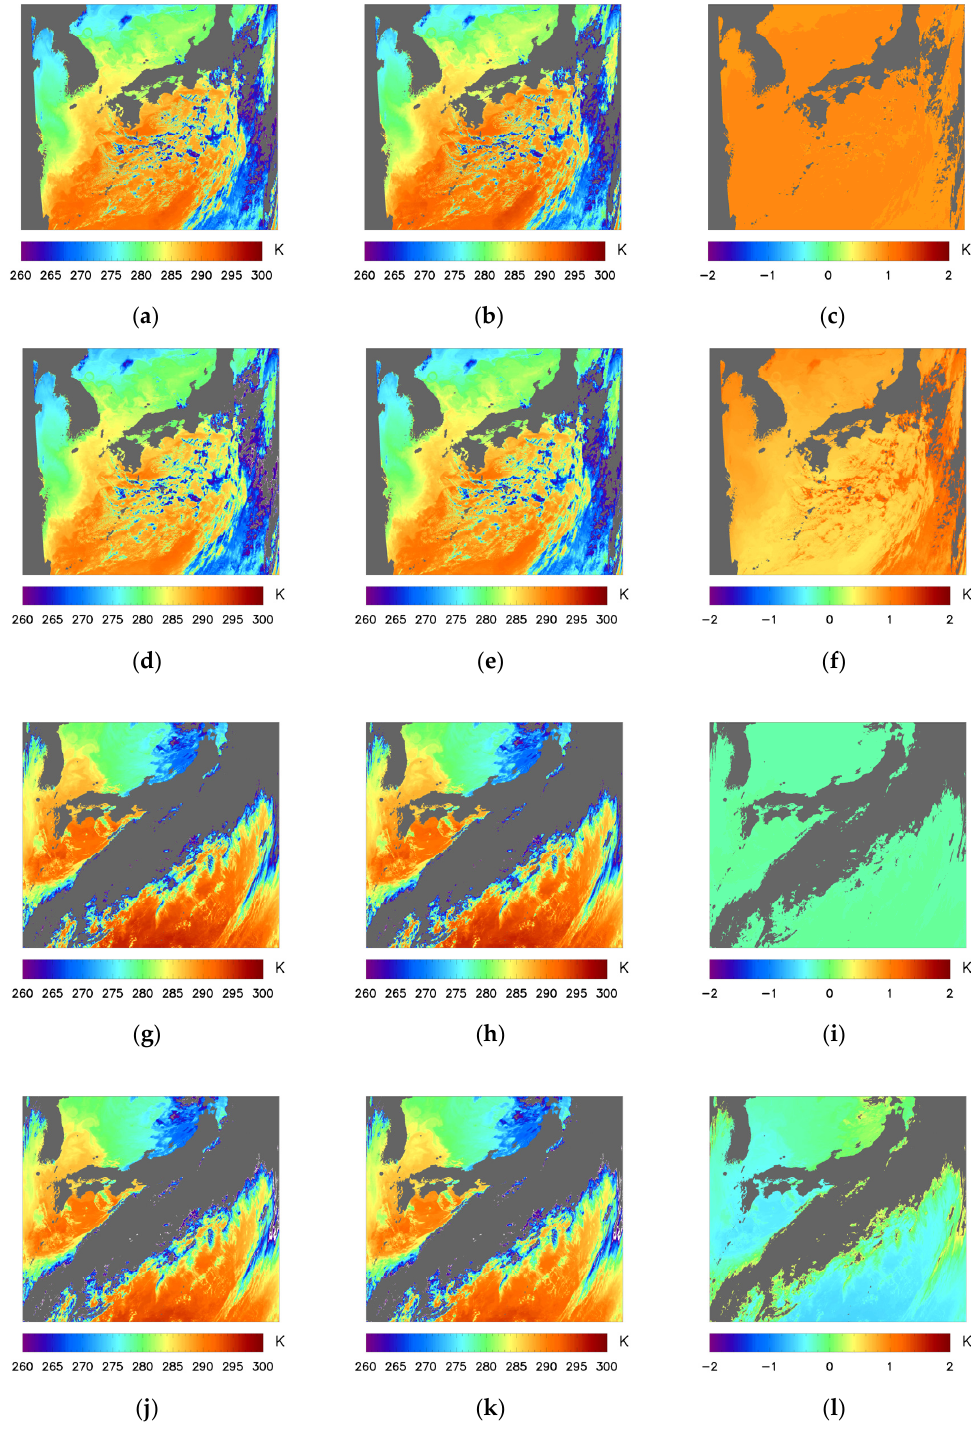
Figure 5. VIRR LI BT before and after calibration and the difference: ( a ) VIRR_BT 11 μ m (daytime); ( b ) VIRR_COR 11 μ m (daytime); ( c ) difference 11 μ m (daytime); ( d ) VIRR_BT 12 μ m (daytime); ( e